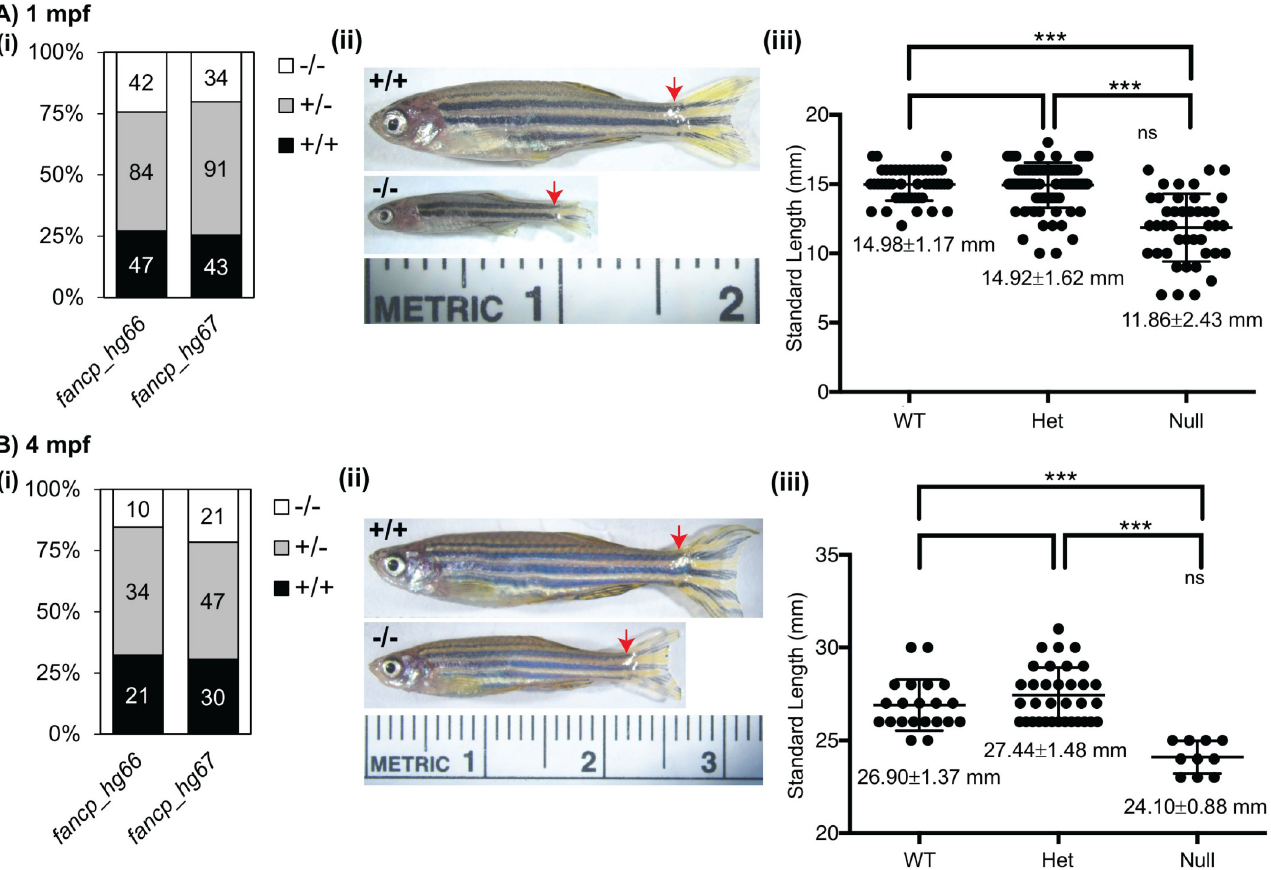
Fig 4. Homozygous fancp mutants are significantly smaller in body length than their siblings. Standard length measurements of fancp fish at 1 mpf (A), and 4 mpf (B). (i) Number of fish genotyped and measured for both fancp alleles: hg66 and hg67. (ii) Representative images of fancp +/+ and fancp hg66/hg66 fish with red arrows marking the beginning of caudal fin used in length measurements. (iii) Data on body size measurements for fancp +/+ , fancp hg66/+ and fancp hg66/hg66 fish. Both time points show a significant decrease in size of fancp hg66/hg66 fish compared to the WT and heterozygous clutch mates (ANOVA analysis, ��� p < 0.001). Data for fancp _hg67 is shown in S8